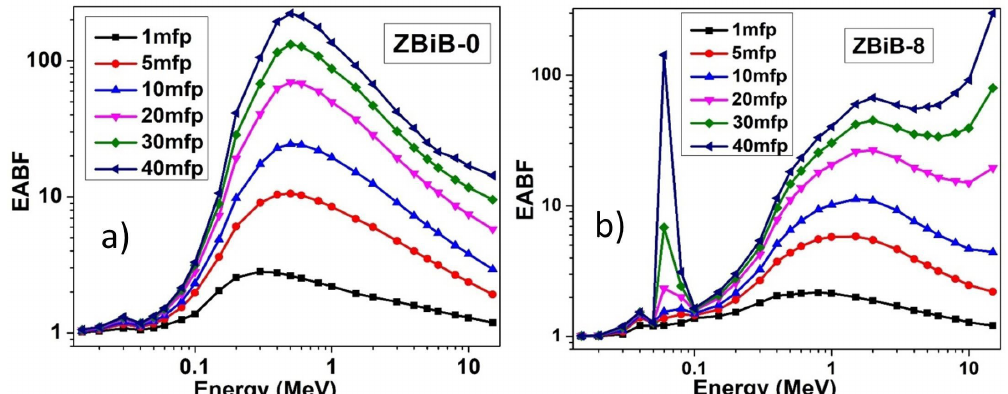
Figure 7. Variation of EABF of ZBiB-0 and ZBiB-8 glass samples with the gamma energy at different mfp in the range of